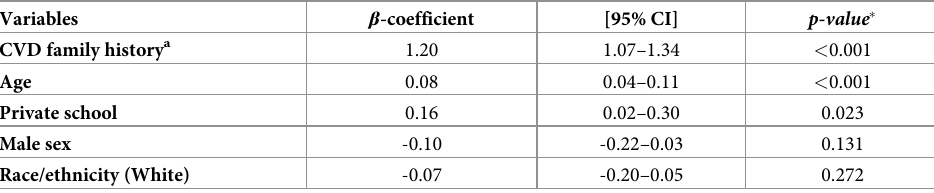
Table 4. Linear regression coefficients for the number of existing modifiable cardiovascular risk